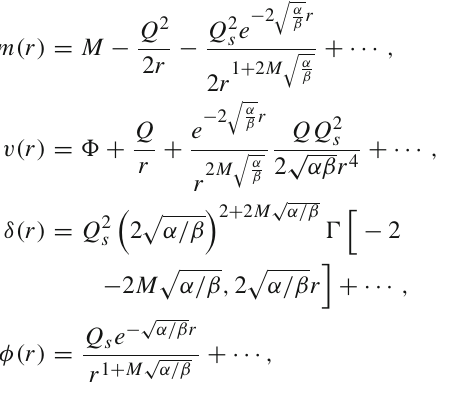
Fig. 5 Five graphs of (cid:14) in e (cid:14) t vs α to determine the thresholds of instability [ α th (β) ] which are the crossing points at α -axis. We read off those as α th (β) = 174.22(200), 132.51(240), 102.29(300), 82.76(380), and